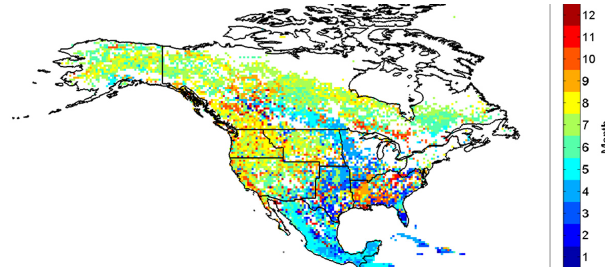
Fig. 2. Peak fire month in North America, defined as the month with the largest fraction of annual GFED burned area during 1997–2010. Colour values from 1–12 indicate the calendar month of peak fire activity for each grid cell.